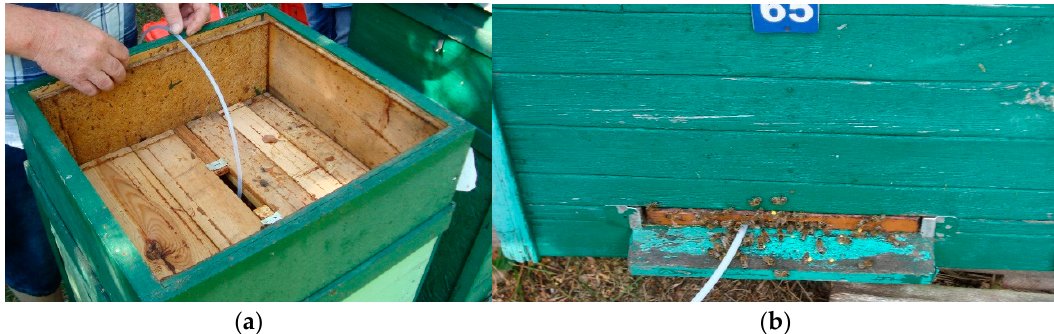
Figure 8. Different location of the sampling point inside the beehive: ( a ) between combs and ( b ) under combs, at the bottom of the beehive.